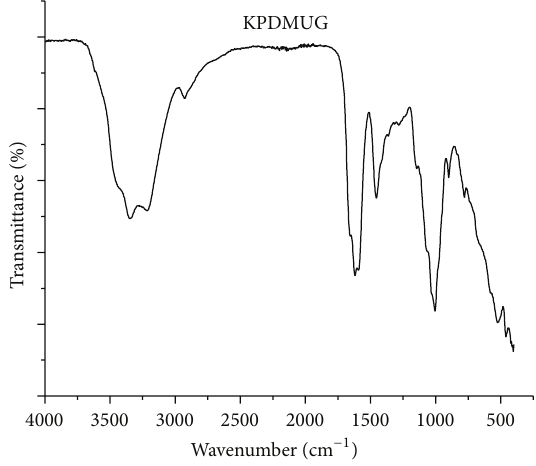
Figure 10: ATR-FTIR spectrum of